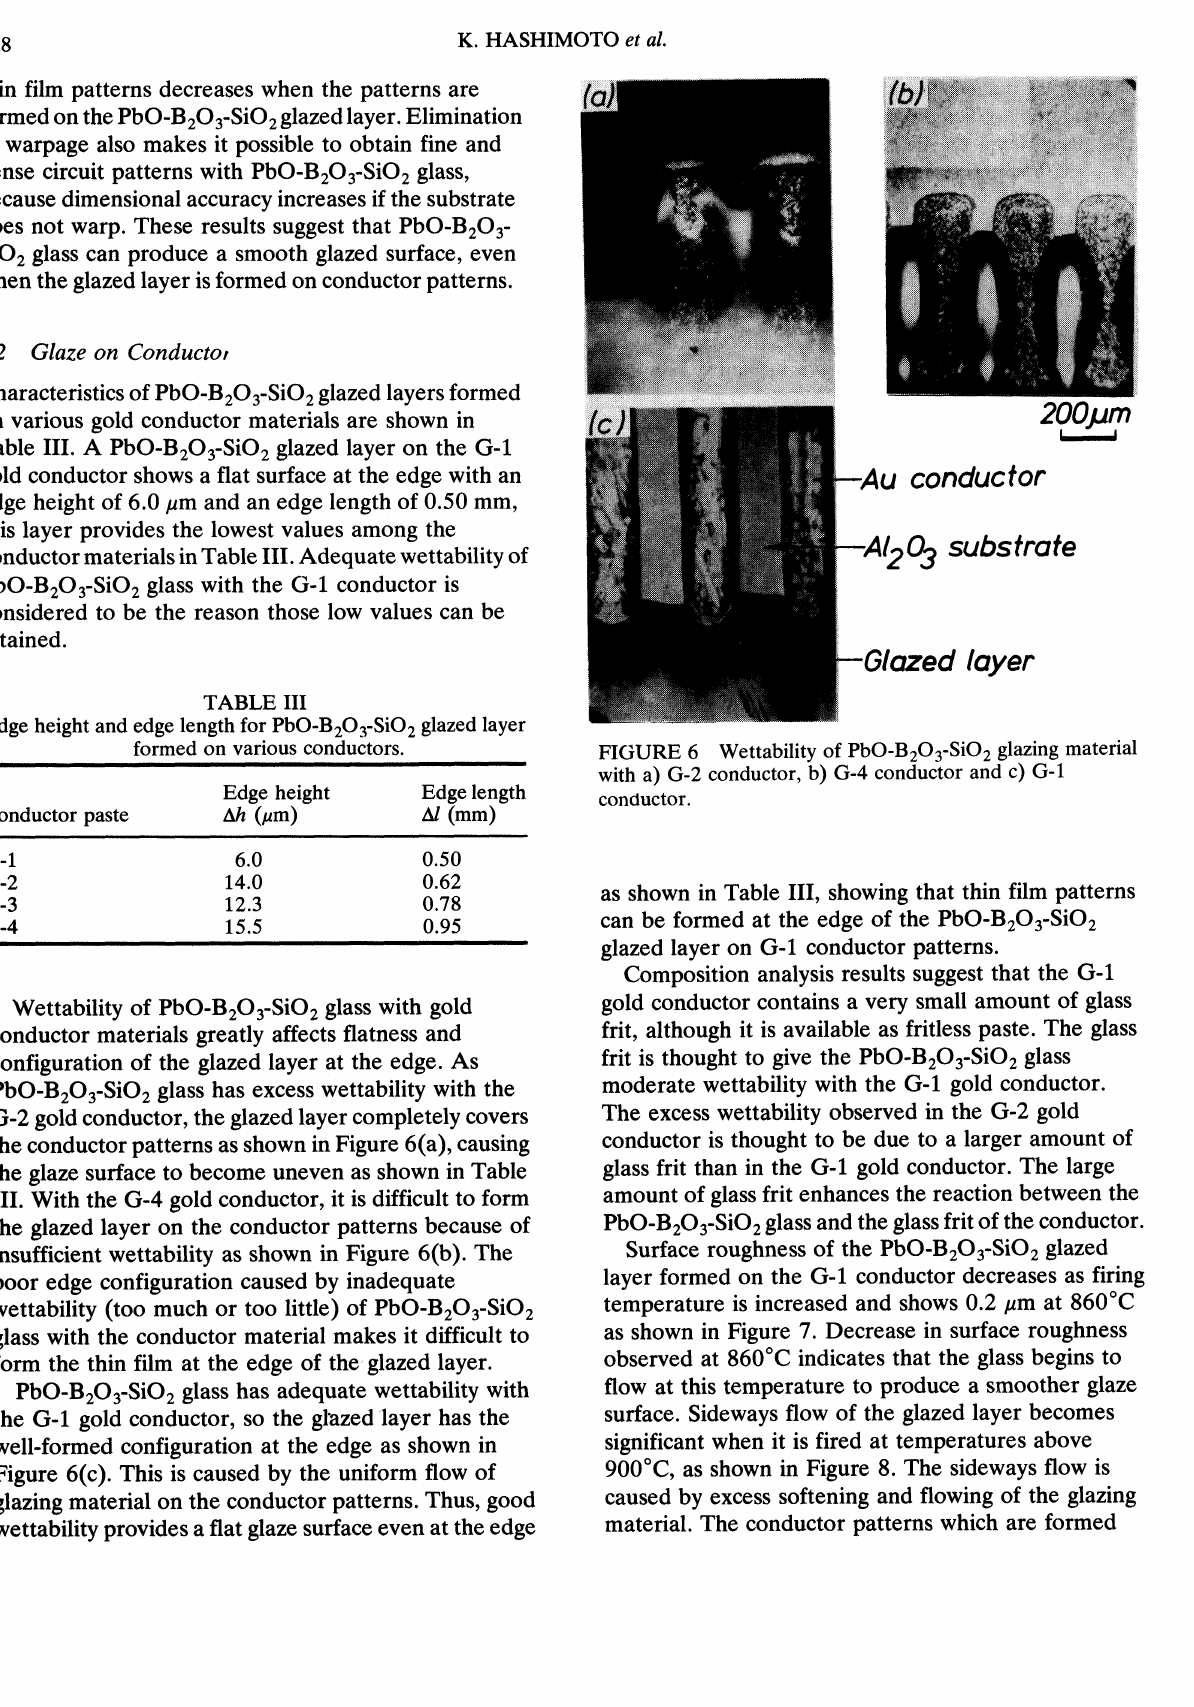
TABLE III Edge height and edge length for PbO-B203-SiO 2 glazed layer formed on various conductors. Edge height